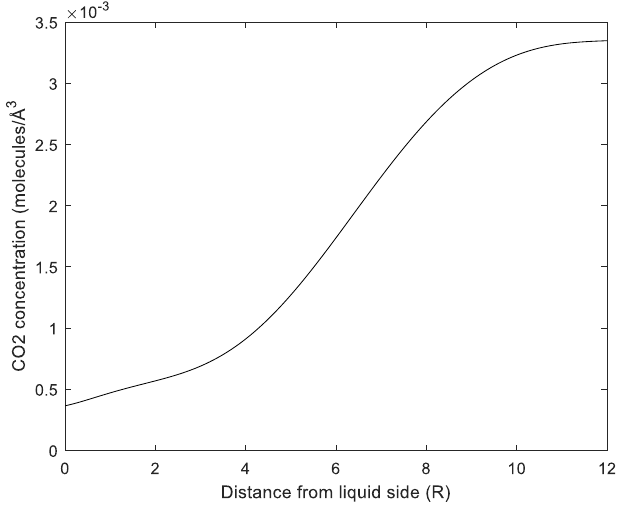
Figure 3. Concentration profile for CO 2 across water ( R = 0)/hydrate ( R = 12) interface [39–41].